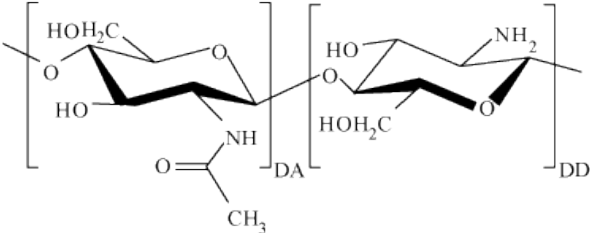
Figure 1. The structural formula of chitosan.